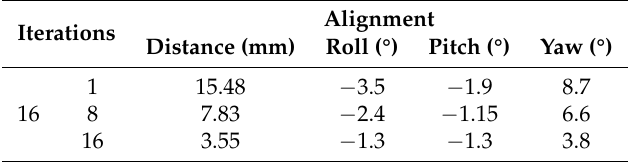
Table 2. Point cloud alignment accuracy using G-ICP algorithm.